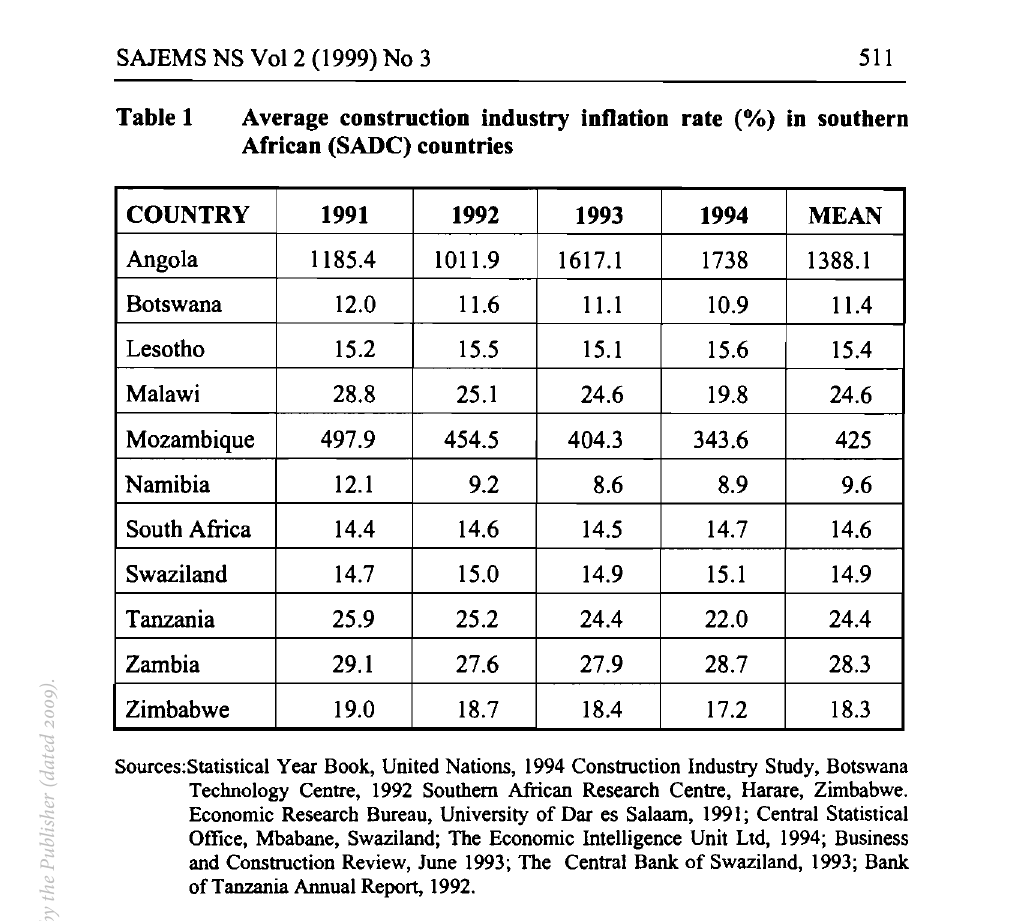
Southern African construction industry indicators, annual rate (%) of change for residential buildings approved plan/investment COUNTRY